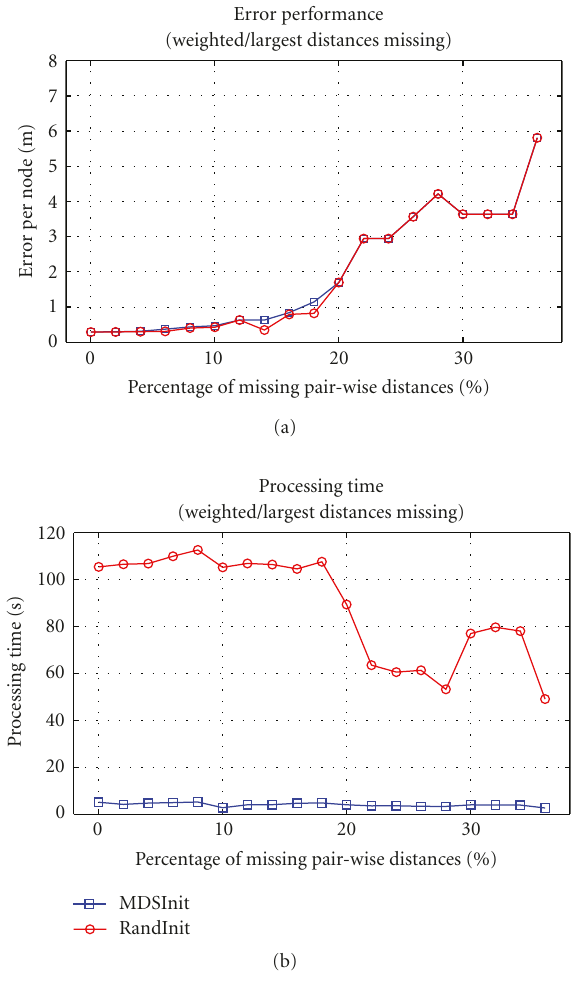
Figure 16: (a) Error performance; (b) processing time versus percentage of missing pairwise distances with standard-deviation adjusted weighting and largest distances missing.